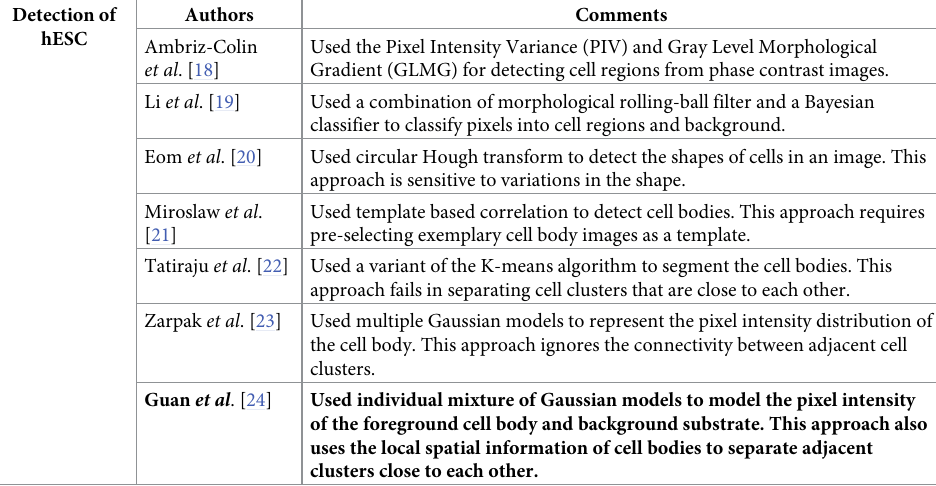
Table 1. Summary of the related work for detecting